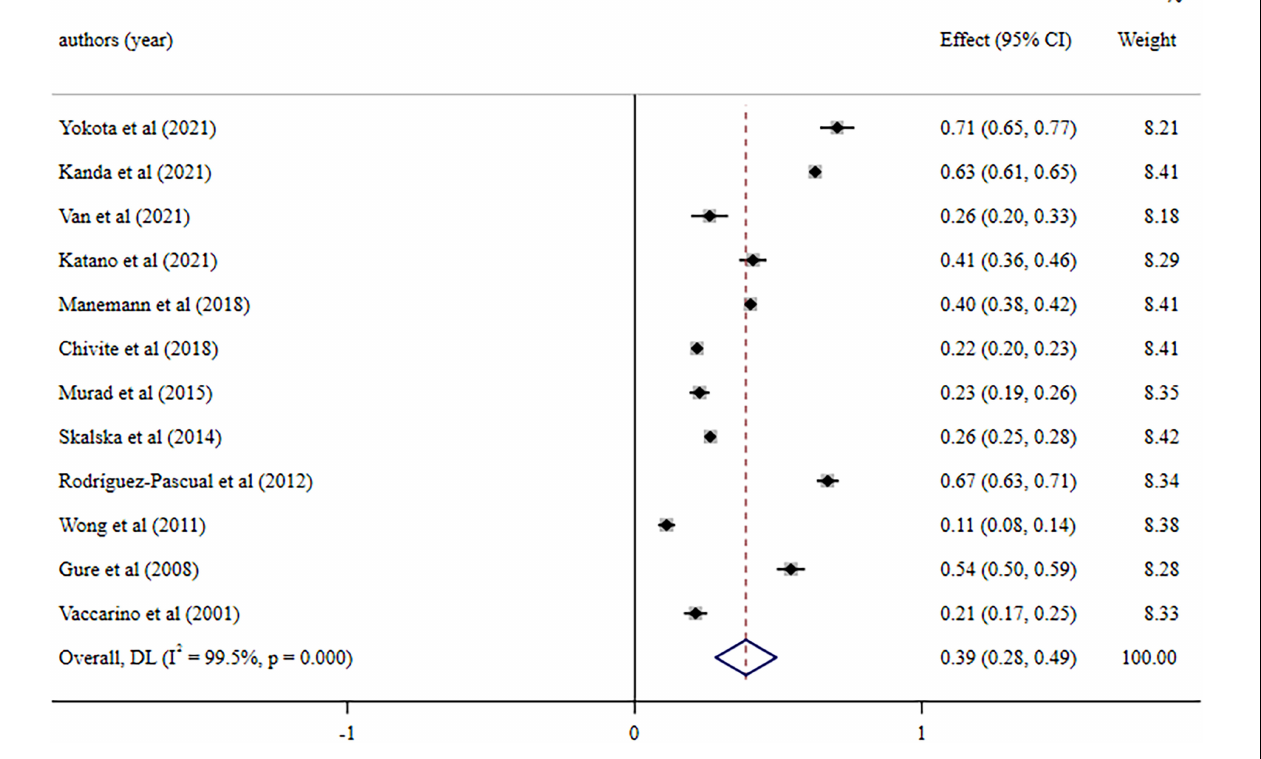
FIGURE 2 | Forest plot of eligible studies. Weights are from random-effects